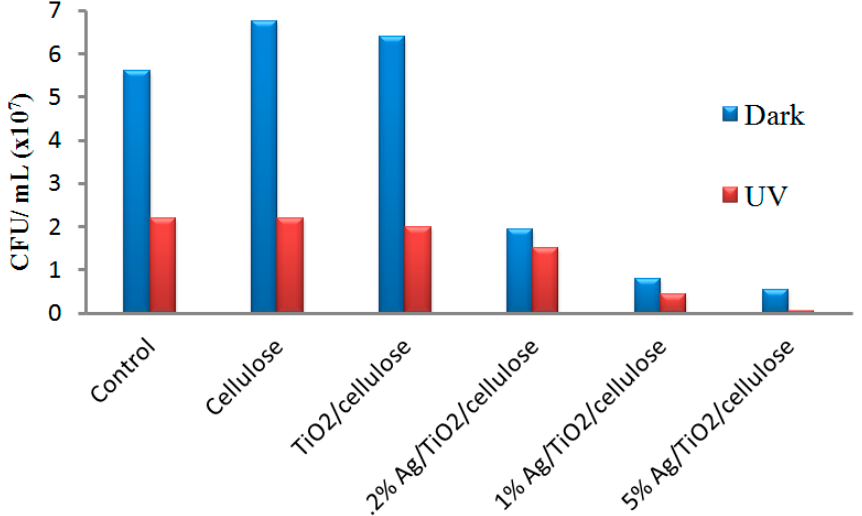
Figure 10. Bar chart of the antibacterial effect of cellulose; TiO 2 /cellulose; Ag/TiO 2 /cellulose composite films with Ag/TiO 2 molar ratios of 0.2%; 1%; and 5% under dark and UV light.